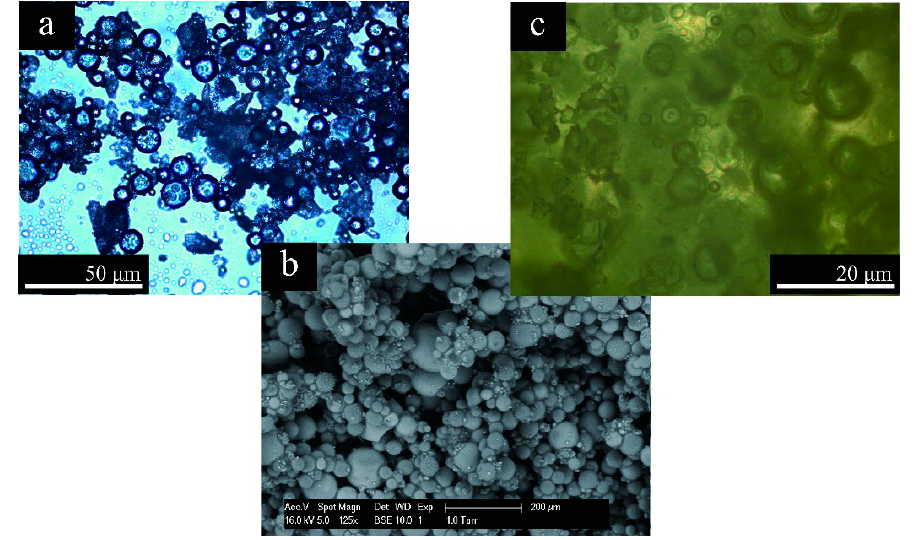
Figure 4. Morphologies of microcapsules/bitumen samples; ( a ) optical microscope morphology of microcapsules in emulsion; ( b ) SEM morphology of microcapsules and ( c ) microcapsules/bitumen composite sample.